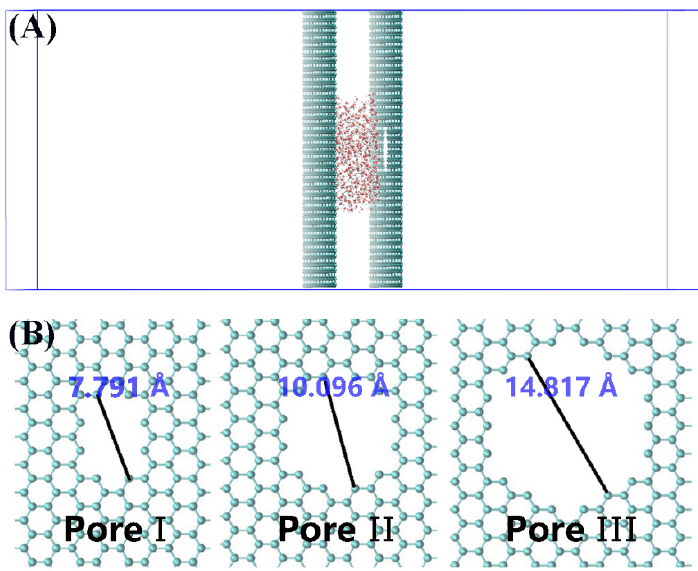
Figure 1. ( A ) Side view of the computational system investigated in this work. ( B ) Typical graphene pores named as Pore-I, Pore-II, and Pore-III by removing 10, 24, and 54 carbon atoms, respectively. Gray spheres represent carbon atoms and red spheres and green spheres represent the oxygen and hydrogen atoms of a water molecule, respectively. The vacancy on graphene represents the nanopore in Figure 1A.